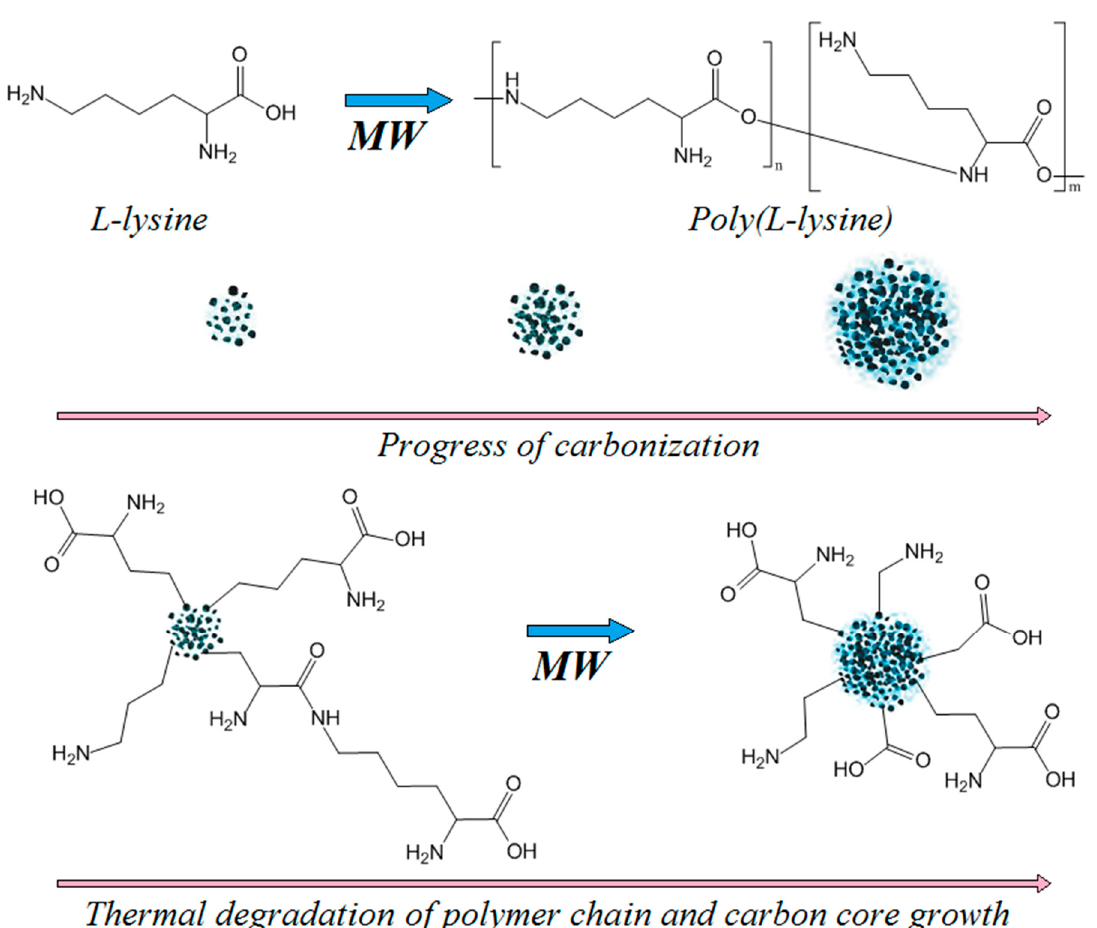
Figure 7. Schematic presentation of CQDs synthesis. Proposed chemical and morphological structure of the CQDs.